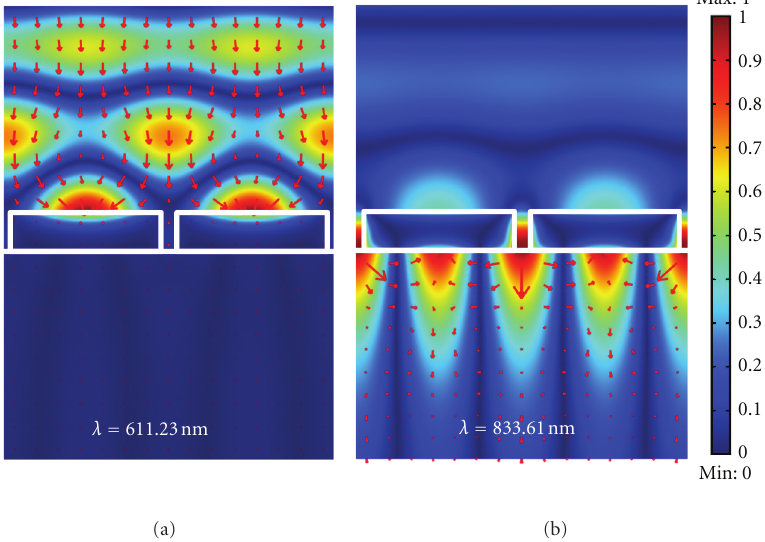
Figure 9: Absolute value of the magnetic field for the equivalent system applied to the case of θ = 10 ◦ ( p eq = 583.88 nm and ε eq = 1.9071). Computations are performed at (a) λ = 611.23 nm and (b) λ = 833.61 nm. Red arrows indicate the Poynting vector direction.